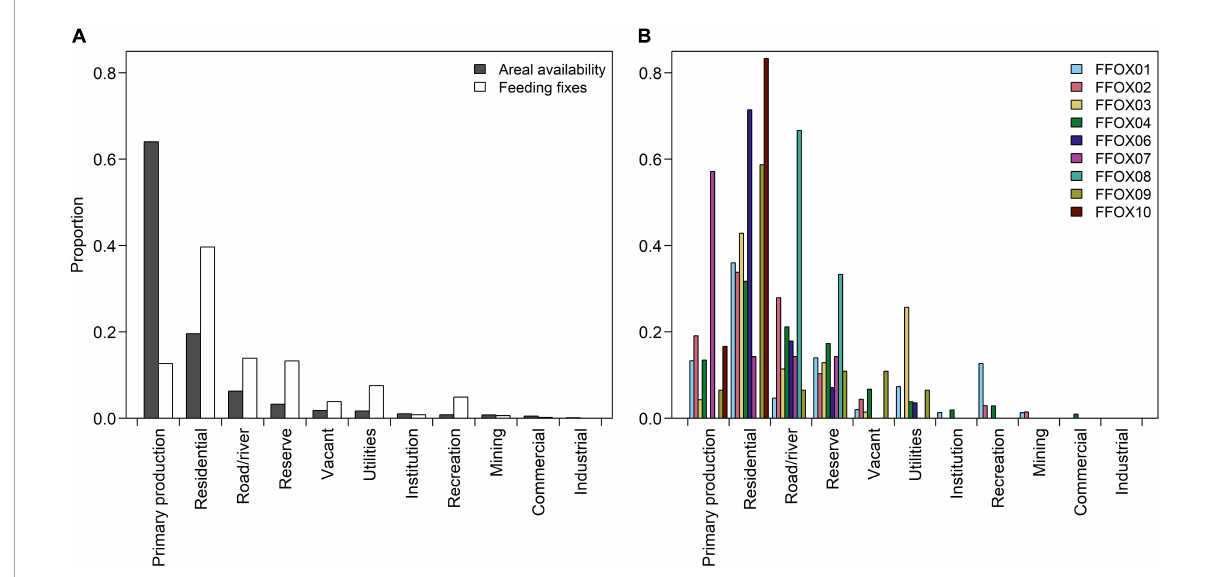
FIGURE3 (A) the expected proportion of Pteropus poliocephalus feeding fixes in each land-use category based on areal availability (grey bars) and the observed proportion of feeding fixes in each land-use category overall (white bars), (B) the observed proportion of feeding fixes in each land-use category shown for each of the nine individuals (shown in different colors). Data ( n = 489) were obtained from GPS tracked P. poliocephalus collected between December 2019 and May